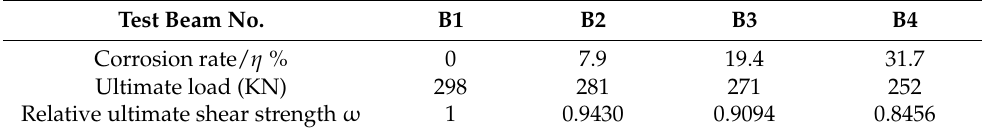
Table 4. Corrosion rate η and relative shear strength ω of test beams.